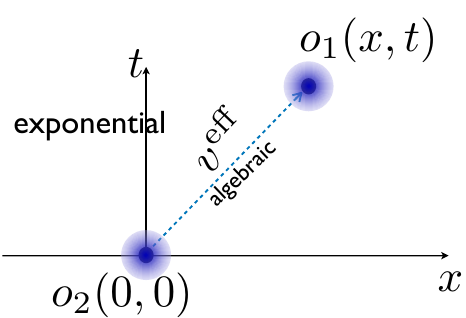
Figure 4: Correlations between observables at the Euler scale are due to propagation of ballistic waves between the two